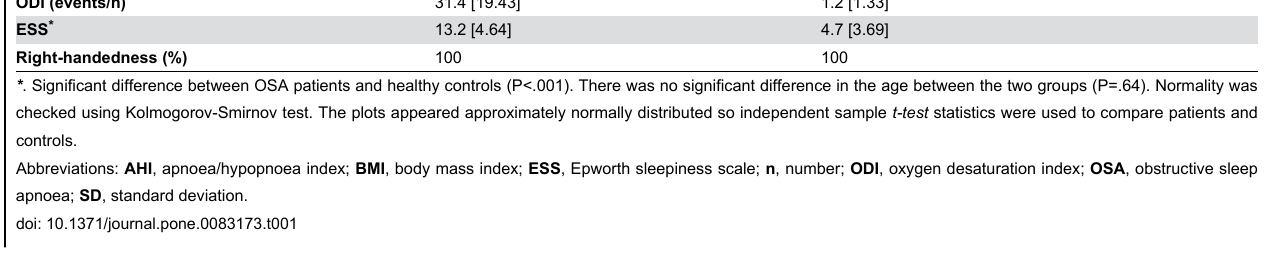
Table 2. Subcortical Volumes as determined by FreeSurfer.